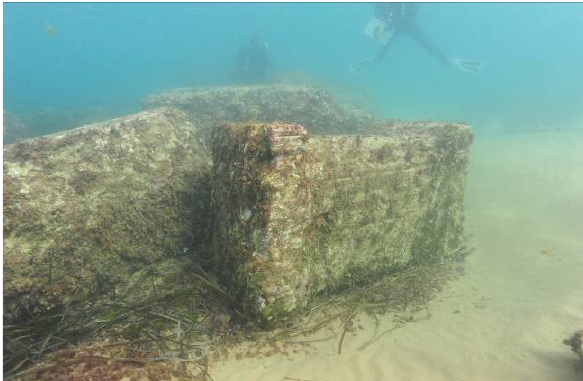
Figure 4. Cape Granitola shipwreck. Detail of a podium. (photo: D. Della